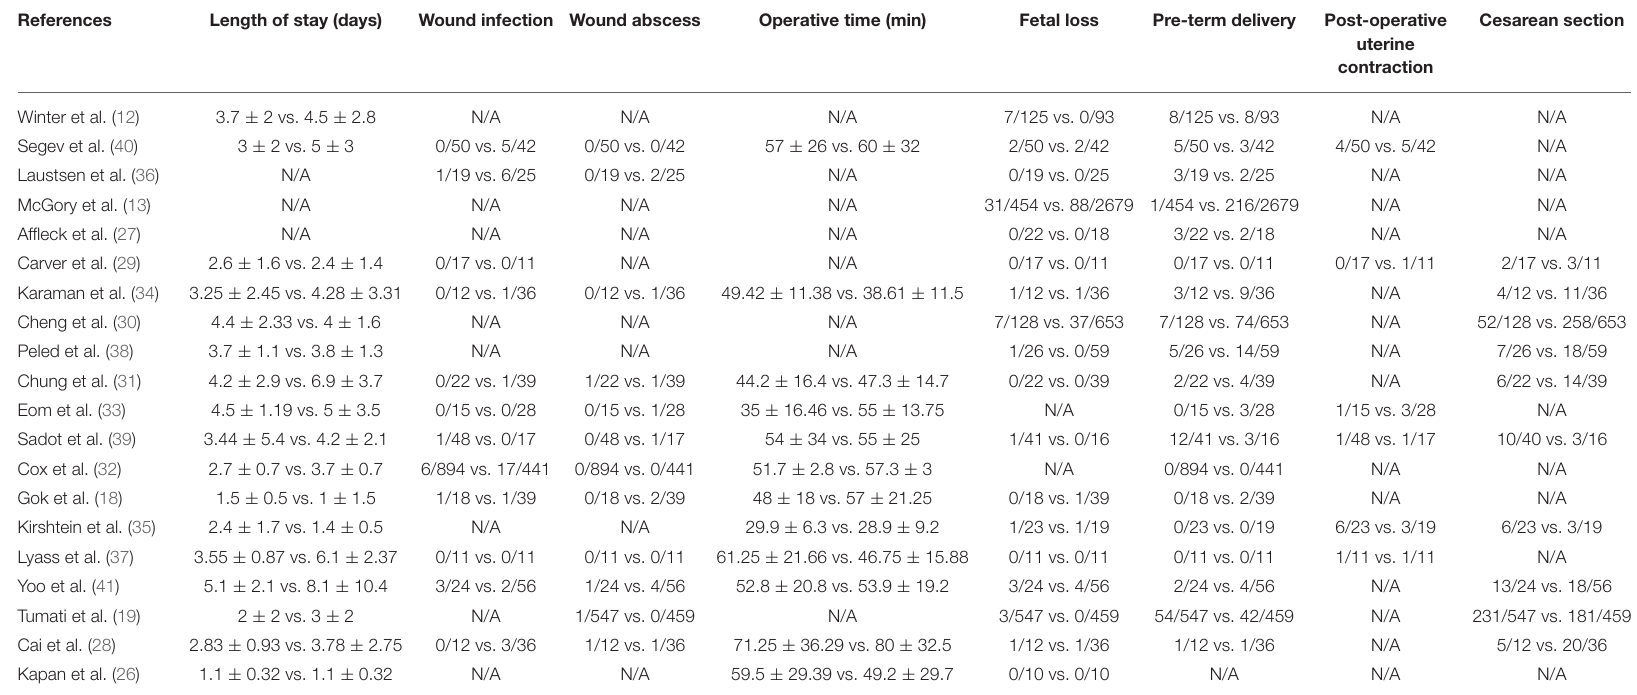
TABLE 2 | Obstetrical and surgical outcomes of included studies (LA vs.